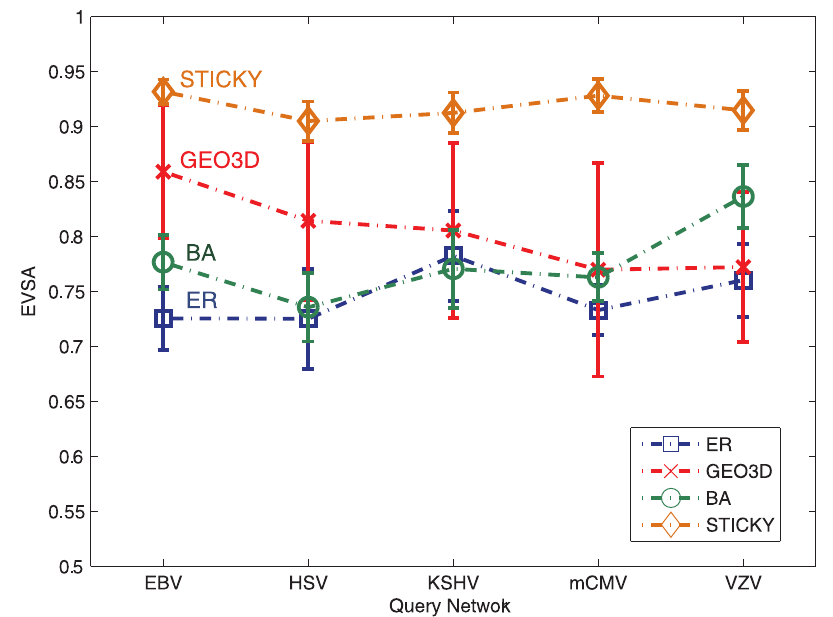
Figure 1. EVSA values of pairwise comparisons between PPI networks of EBV, HSV, KSHV, mCMV and VZV and network generated from ER,GEO3D,BA,STICKY models. The EVSA scores are averaged over 50 simulations and the error bar represents one standard deviation of the EVSA score.